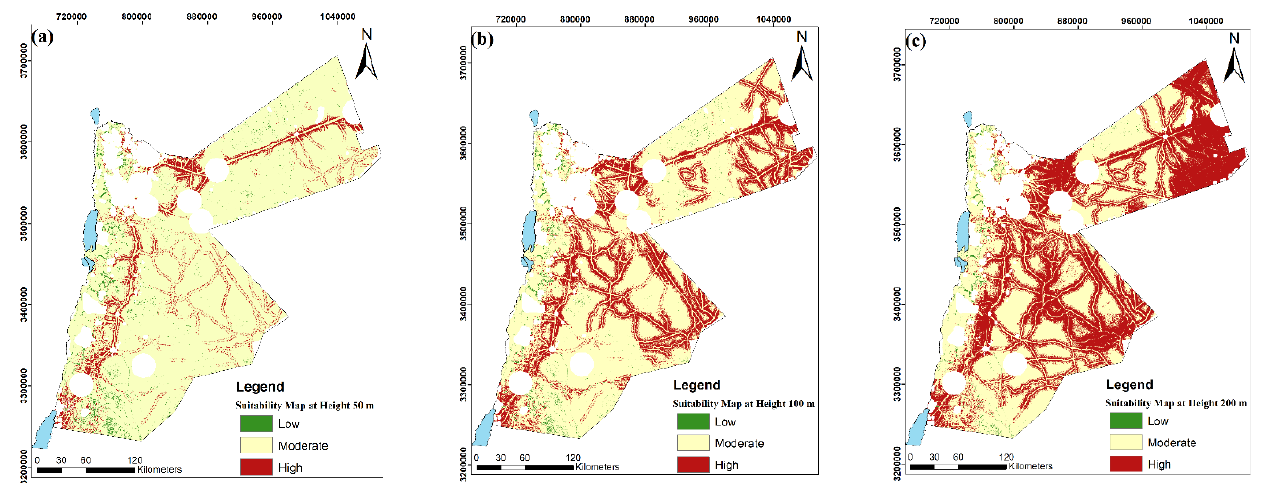
Figure 5. Final wind farm suitability locations at three heights; ( a ) 50 m, ( b ) 100 m, ( c ) 200 m. White areas are the areas excluded from the study due to restrictions on the use of wind turbine farms.